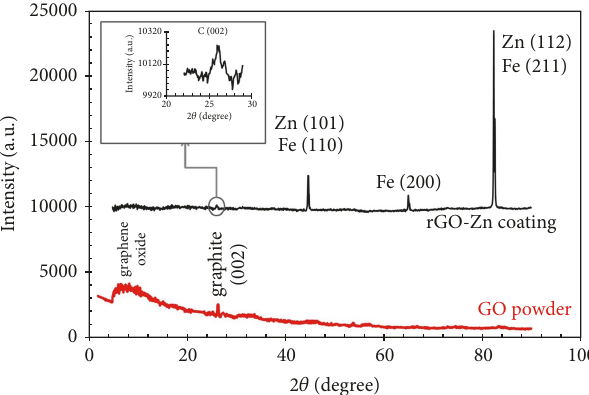
Figure 4: XRD curves of synthesized GO powder according to modified Hummer’s method and rGO-Zn coating produced by pulse-potential electrodeposition